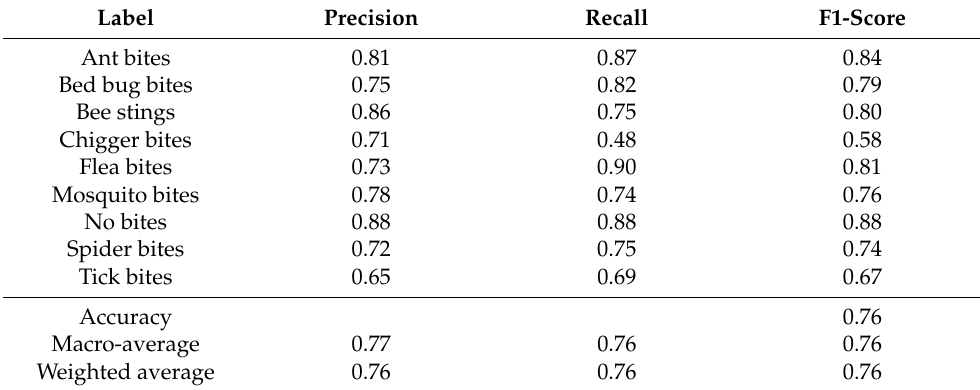
Table 11. Evaluation metrics for VGG16 model.